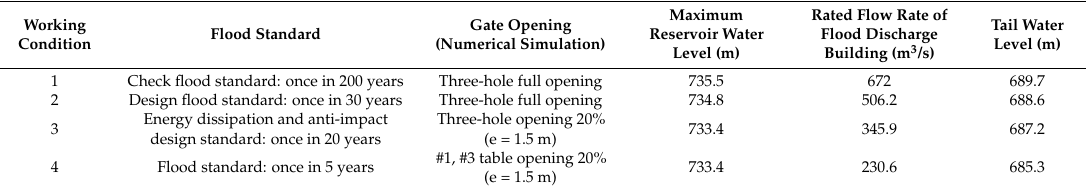
Table 5. Characteristics of the water level and discharge conditions used in the numerical simulations.